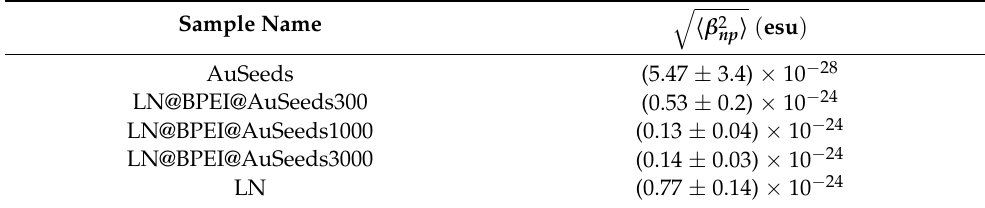
Table 2. First hyperpolarizability values determined from the slope of the HRS intensity plots vs